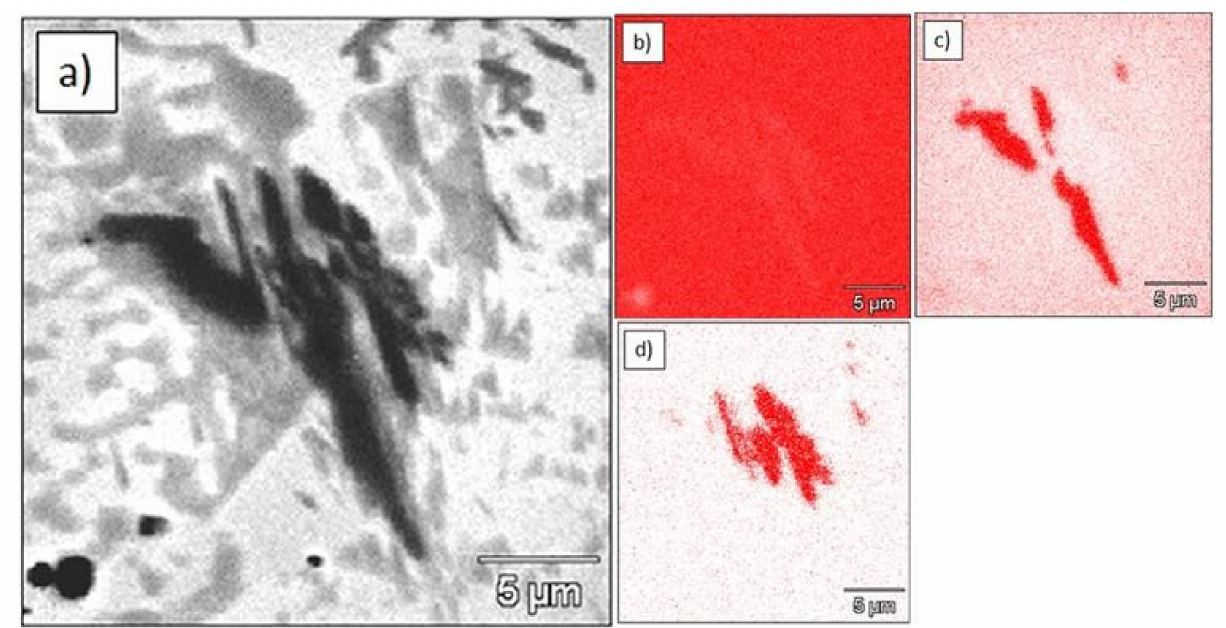
Figure 5. Microstructure and elemental maps of Ti-0.5%TiC sinter: ( a ) microstructure; ( b ) elemental map of titanium (EDS); ( c ) elemental map of carbon (WDS); ( d ) elemental map of boron (WDS). EBSD analysis confirmed the presence of TiC (cubic; space group 225; unit cell lengths: 0.433, 0.433, 0.433 nm) and TiB (orthorhombic; space group 62; unit cell lengths: 0.612, 0.306, 0.456 nm; Figure 6).